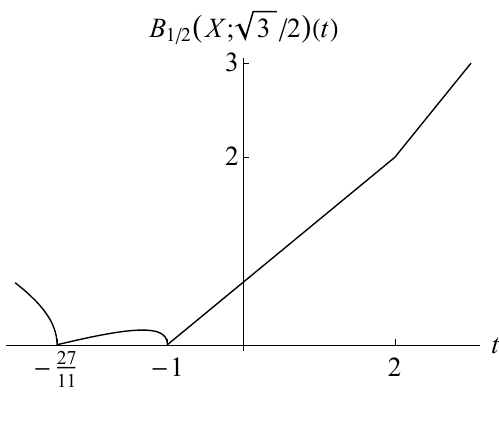
Figure 3. Illustration of Example